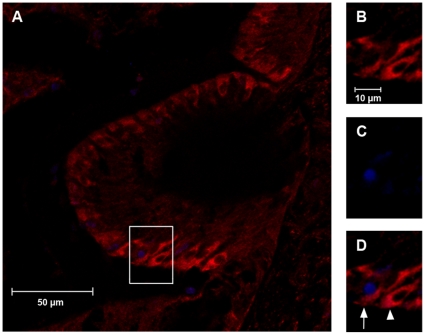
Some new cells produced by miR181a transfection express the early hair cell marker myosin VI.Shown is a confocal image of a basilar papillae that was transfected with pre-miR181a, cultured for 72 hours, then cryosectioned and labeled for BrdU (blue) and the early hair cell marker myosin VI (red) (A). The apical surface of hair cells is to the left of the image and the neural edge of the basilar papillae is toward the bottom. The tectorial membrane has been removed to allow for antibody labeling. The inset of A is also shown in panels B (myosin VI), C (BrdU) and D (merge). The arrow in D shows a cell that expresss myosin VI and has a BrdU positive nucleus, whereas the arrowhead shows a cell that is labeling for myosin VI but not BrdU. The double-labeled cell is one that has been stimulated to divide and subsequently begin differentiating toward a hair cell phenotype. The scale bar in B also applies to C and D.